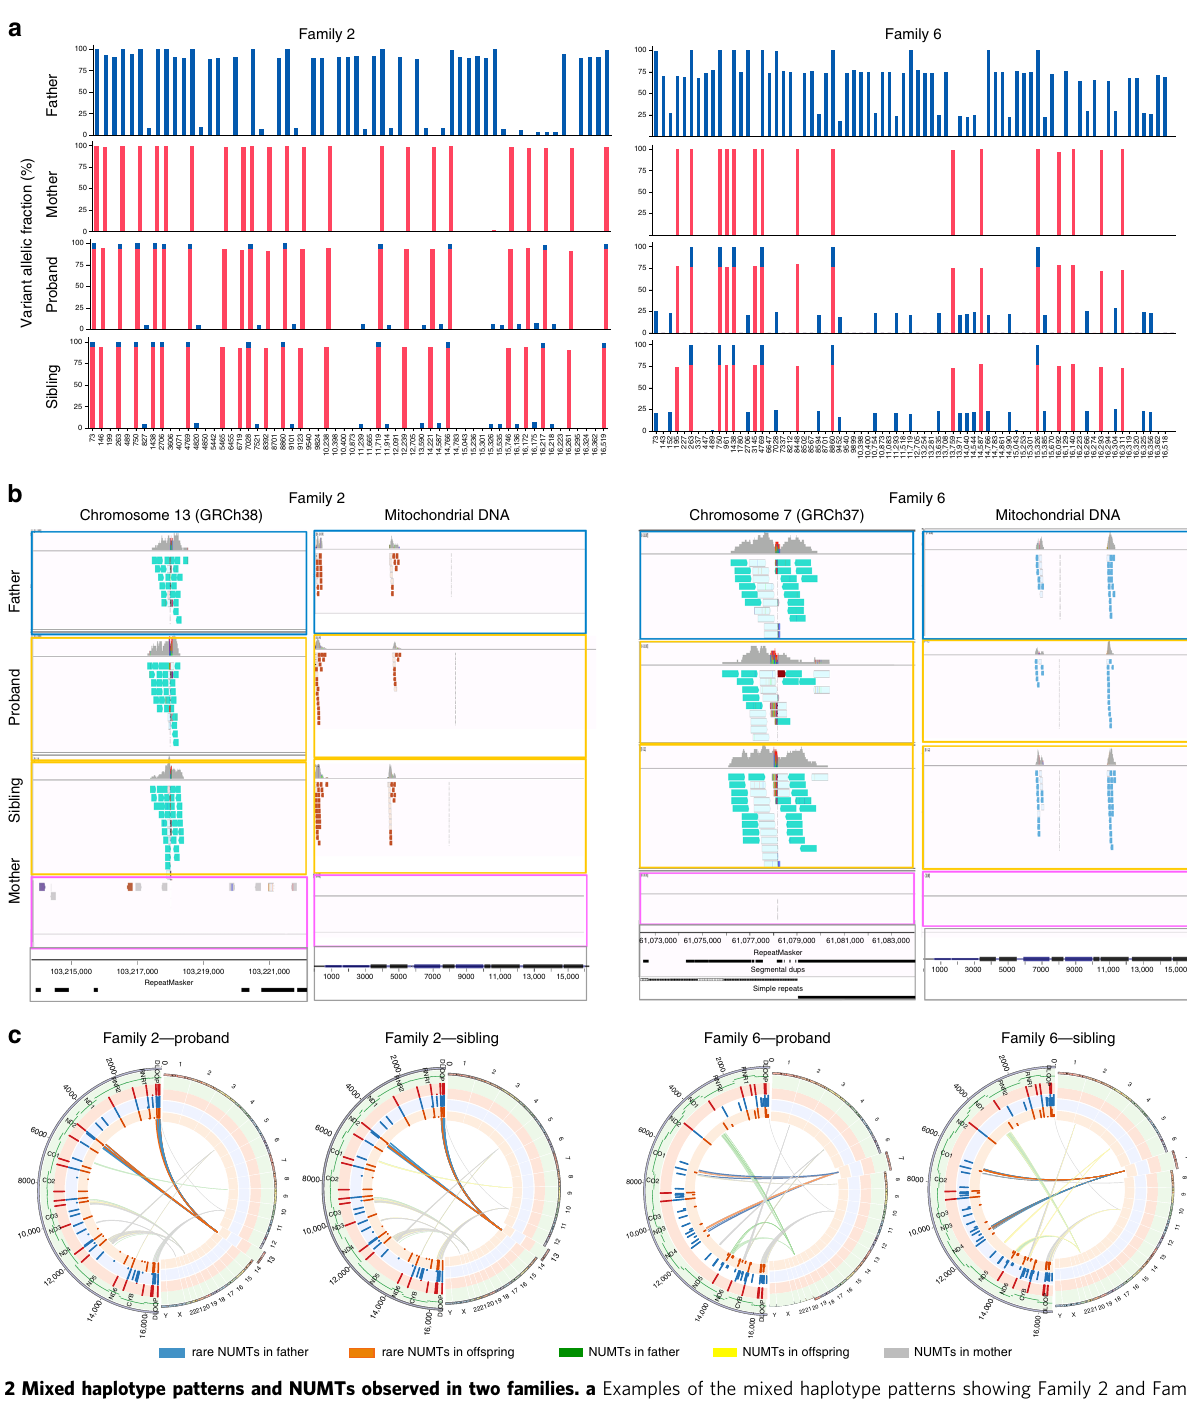
Fig. 2 Mixed haplotype patterns and NUMTs observed in two families. a Examples of the mixed haplotype patterns showing Family 2 and Family 6. Father and both offspring show the mixed haplotypes with the similar HFs in each family. The mixed haplotype patterns observed in the other fi ve families are shown in Supplementary Fig. 2. b Screenshots from Integrative Genomics Viewer (IGV) showing aligned reads corresponding to the rare NUMTs. The alignment of the discordant and split reads corresponding to the NUMTs on the nuclear DNA (left) and mtDNA (right) in two families. Teal bars indicate the aligned reads which mapped to the nuclear DNA where their mates mapped to the mtDNA (left). The chromosomes on which their mates are found are shown in different colours (right). The genome position, repeats and segmental duplications tracks from UCSC genome browser are shown at the bottom. IGV Screenshots from all aligned reads corresponding to the rare NUMTs on the nuclear DNA are shown in Supplementary Fig. 3. IGV screenshots of the other fi ve families are shown in Supplementary Fig. 4. c Circos plots show the observed variants and NUMTs in two families. Circles from the outside to the inside indicate the following: (1) position of a variant on the mtDNA; (2) regions corresponding to the different mtDNA genes; (3) variants identi fi ed in the mother where the radial axis corresponds to the VAF; (4) variants identi fi ed in the father; (5) variants identi fi ed in the offspring, proband (left) and sibling (right) are shown, respectively; (6) NUMTs observed in the family, proband (left) and sibling (right) are shown,